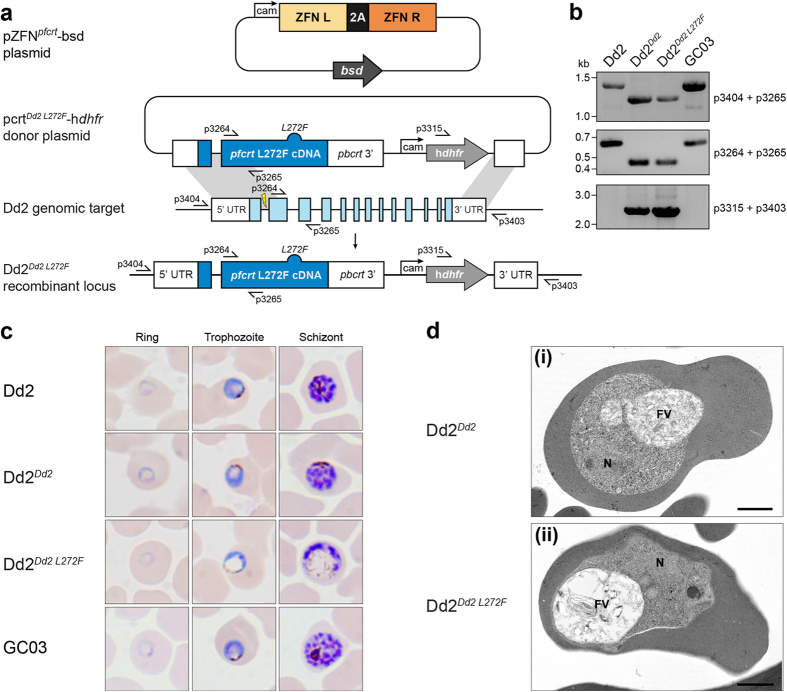
Introduction of PfCRT L272F into Dd2.(a) Schematic of zinc-finger nuclease (ZFN)-mediated generation of vacuole-enlarged parasites. Dd2 parasites were first enriched for the episomal pcrtDd2 L272F-hdhfr or pcrtDd2-hdhfr donor plasmids (latter not shown). The donor plasmids encoded a cDNA copy of the Dd2 pfcrt allele (dark blue, plasmid), either L272F-mutated (dark blue bump) or wild-type (not shown), followed by a dhfr selection cassette (light grey). Each donor-enriched parasite was then transfected with the pZFNpfcrt-bsd plasmid, expressing the genomic (light blue) pfcrt intron 1-targeting ZFN pair (ZFN L and ZFN R, orange) and the bsd selection cassette (dark grey). ZFN-induced recombination in pfcrt yielded either control Dd2Dd2 (not shown) or Dd2Dd2 L272F parasites (dark blue, locus). (b) PCR verification of parental, recombinant control, and Dd2Dd2 L272F parasite clones. Primer (p) positions are shown in panel a. (c) Light microscope analysis of representative examples of parental, recombinant control, and experimental parasite clones. Ring morphology for each parasite Dd2, Dd2Dd2, Dd2Dd2 L272F, and GC03 was normal. Progression through the trophozoite and schizont stages showed normal morphological development except for the Dd2Dd2 L272F clone, which exhibited the characteristic enlarged vacuole and diffuse hemozoin phenotypes seen in 3D7L272F and FCBC101F Giemsa stained parasites. (d) Transmission electron micrographs of Dd2Dd2 (i) and Dd2Dd2 L272F parasites (ii) showing similar cytoplasmic appearances except for the enlarged food vacuole (FV) in Dd2Dd2 L272F. Note neither parasite exhibits knobs. This confirms similar morphological appearances to those of 3D7 and 3D7L272F, respectively but without knob formation. N—Nucleus. Bars represent 1 μm.